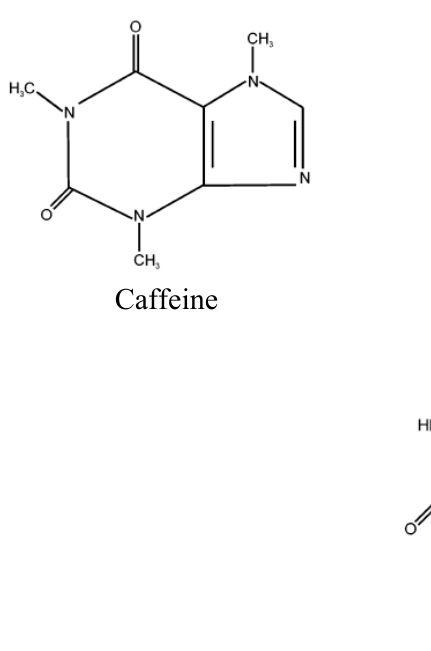
Figure 4. Methyxanthines present in cocoa